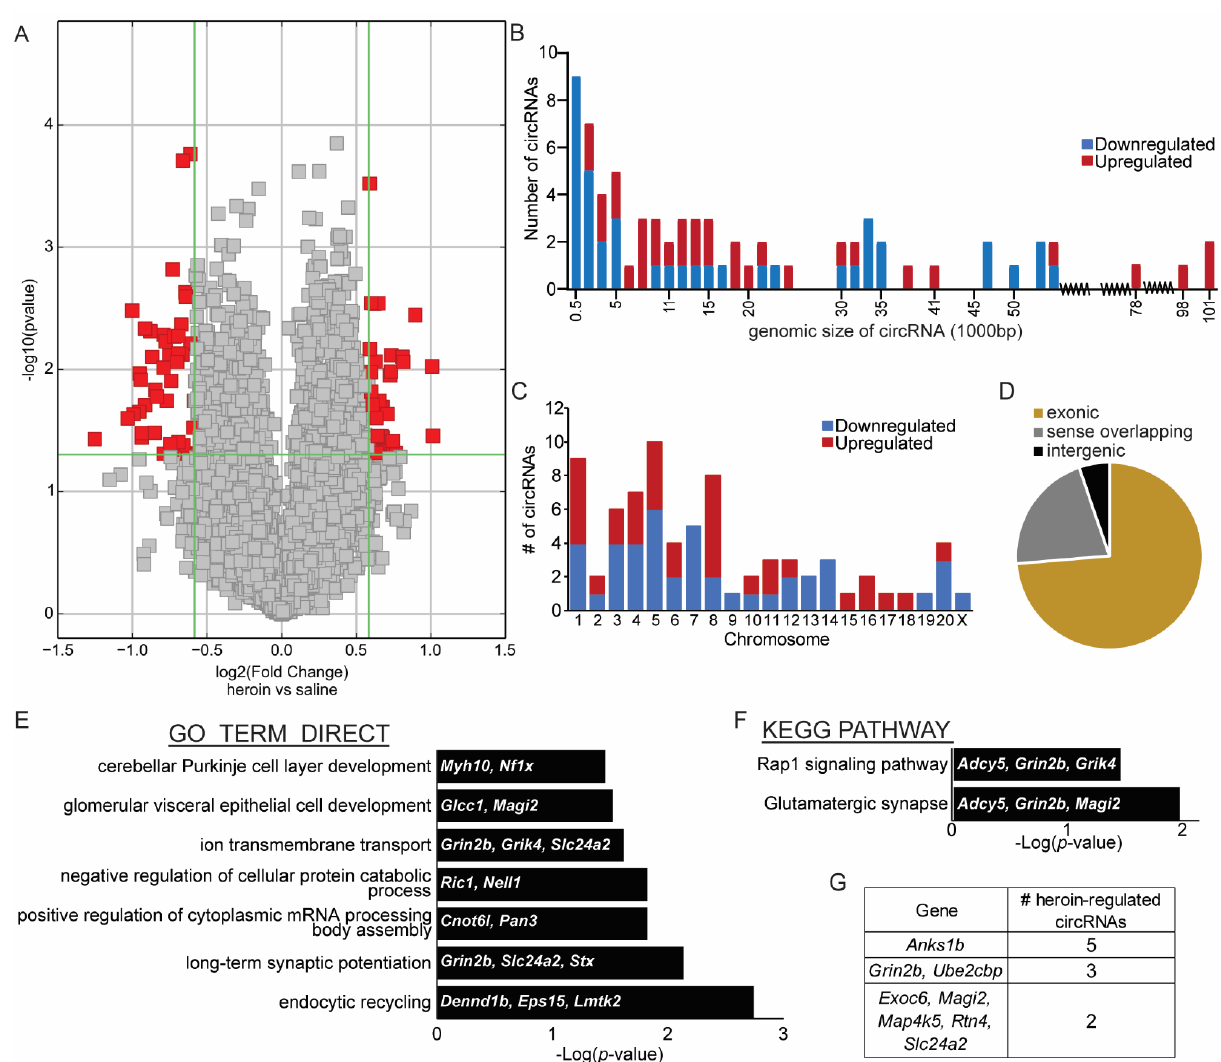
Figure 2. Heroin-associated circRNAs are derived from genes distributed across the genome and are mostly exonic. ( A ) Volcano plot depicting differentially expressed circRNAs in the OFC after heroin self-administration, as measured by microarray analyses. Red dots indicate circRNAs that meet statistical criteria for significantly different compared to saline. Grey dots represent circRNAs that are not statistically different between heroin and saline. ( B ) Genomic size in base pairs (bp) of each circRNA differentially expressed between heroin and saline animals, as indicated by the beginning and end position of the circRNA’s backsplice junction. ( C ). Chromosomal location of each differentially regulated circRNA. ( D ) Pie graph depicting the proportions of heroin-associated circRNAs that are exonic, intergenic, or sense overlapping. ( E , F ) Results from gene ontology analyses ( E ) and KEGG pathway analyses ( F ) indicating the terms significantly enriched from the gene list of linear mRNAs that give rise to differentially expressed heroin-associated circRNAs. For each term, the genes identified in the microarray analysis that belong to the term list are indicated. ( G ) List of repeat heroin-associated circRNAs that are derived from the same linear gene.